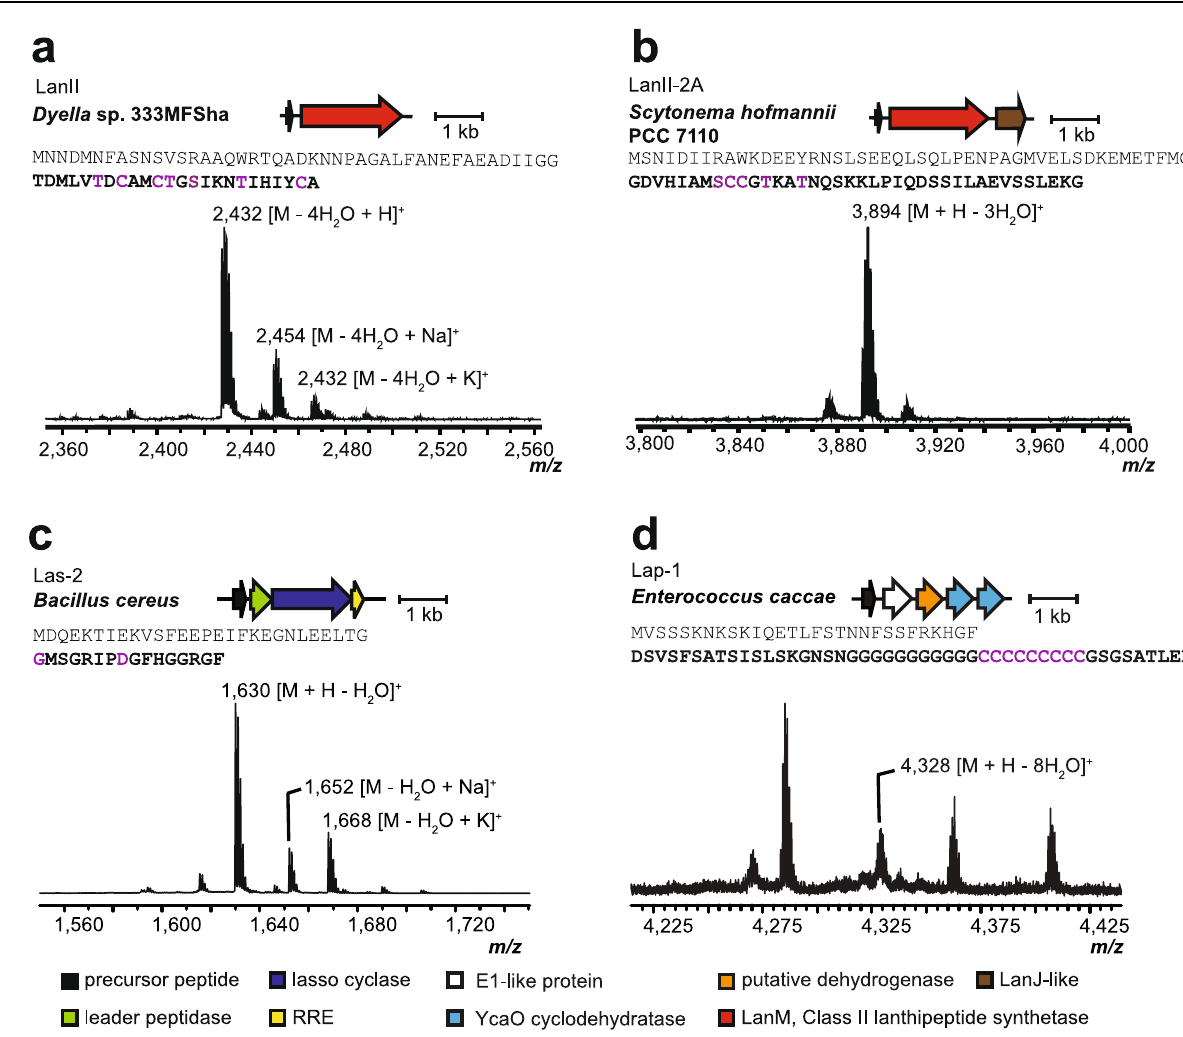
Fig. 5 | MALDI-TOF MS data of representative products from refactored RiPP BGCs. Products of the refactored BGCs of a LanII, b LanII-2A, c Las-2, and d Lap-1. Shown are the producing organism, gene diagram for the BGC, sequence of the precursorpeptidewiththepredictedcorepeptideboldedandthelocationofPTMs